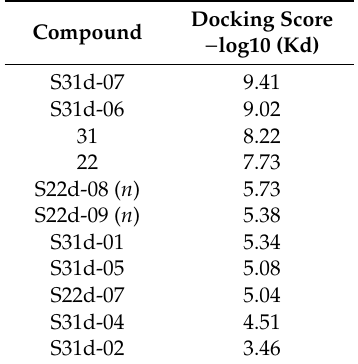
Table 4. HDAC4 Docking scores of cyclopropane derivatives having heteroaromatic rings in the lower selectivity